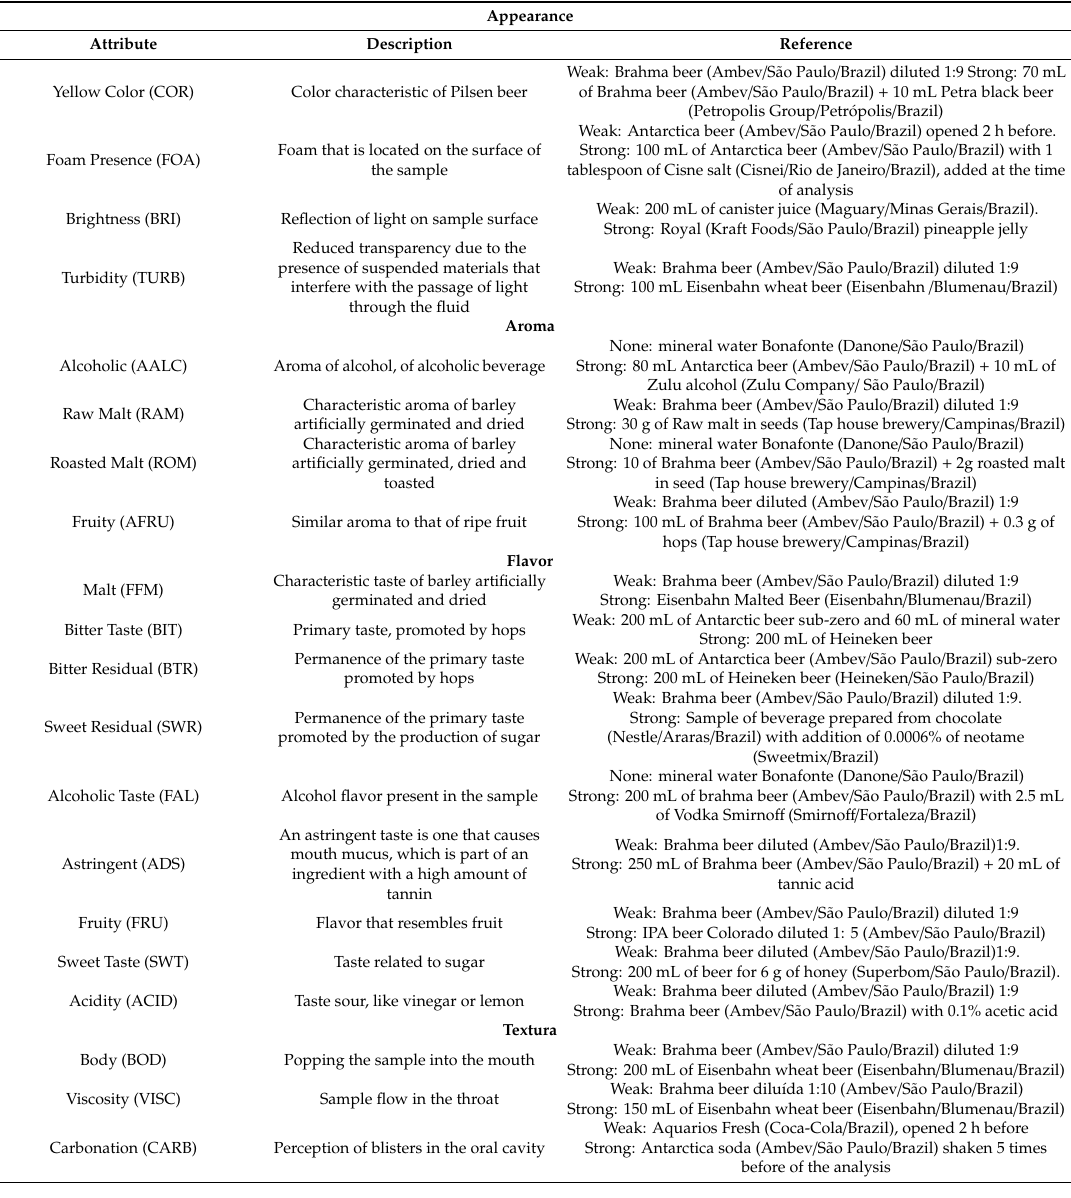
Table 1. Definition of terms descriptors and references used in quantitative descriptive analysis (QDA ®